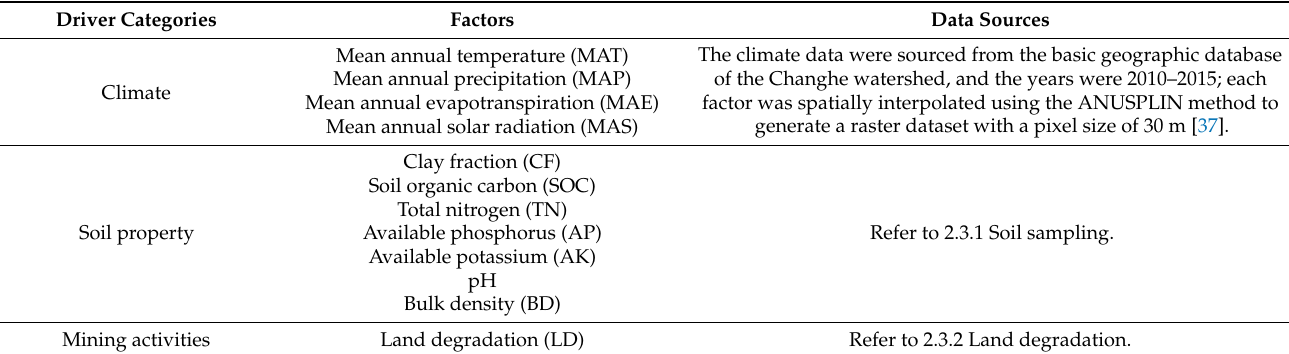
Table 1. The composition of driving